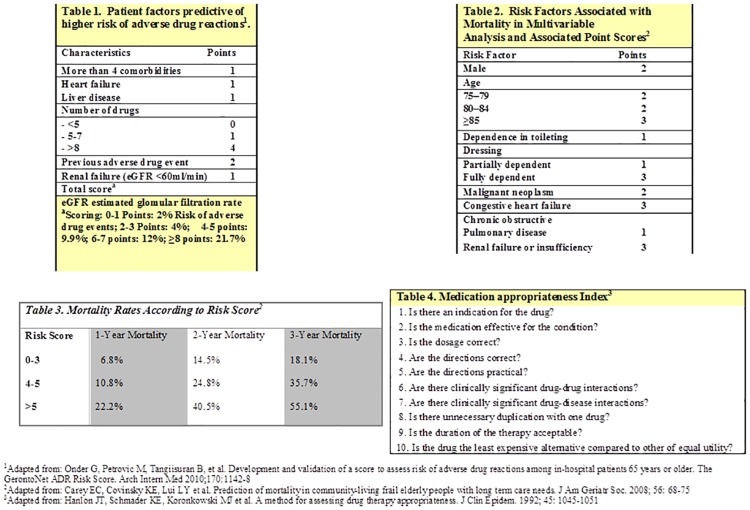
Checklist page 2.